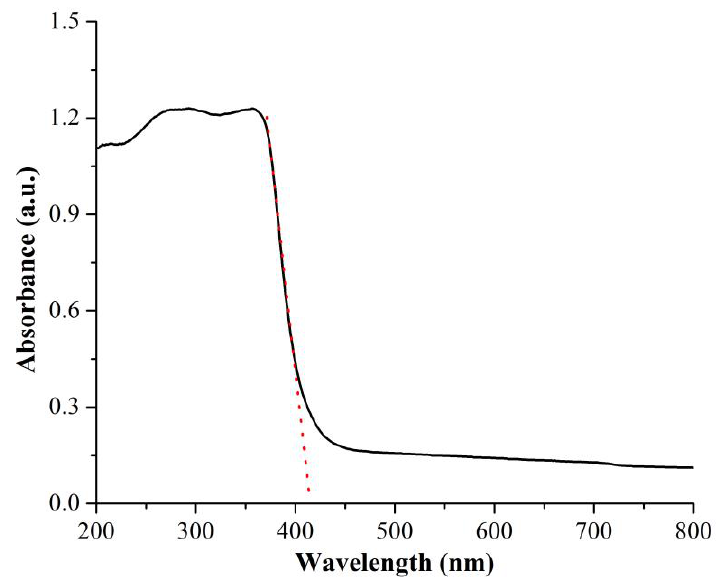
Figure 5. UV – Vis DRS of ZnO NPs. Figure 5. UV–Vis DRS of ZnO